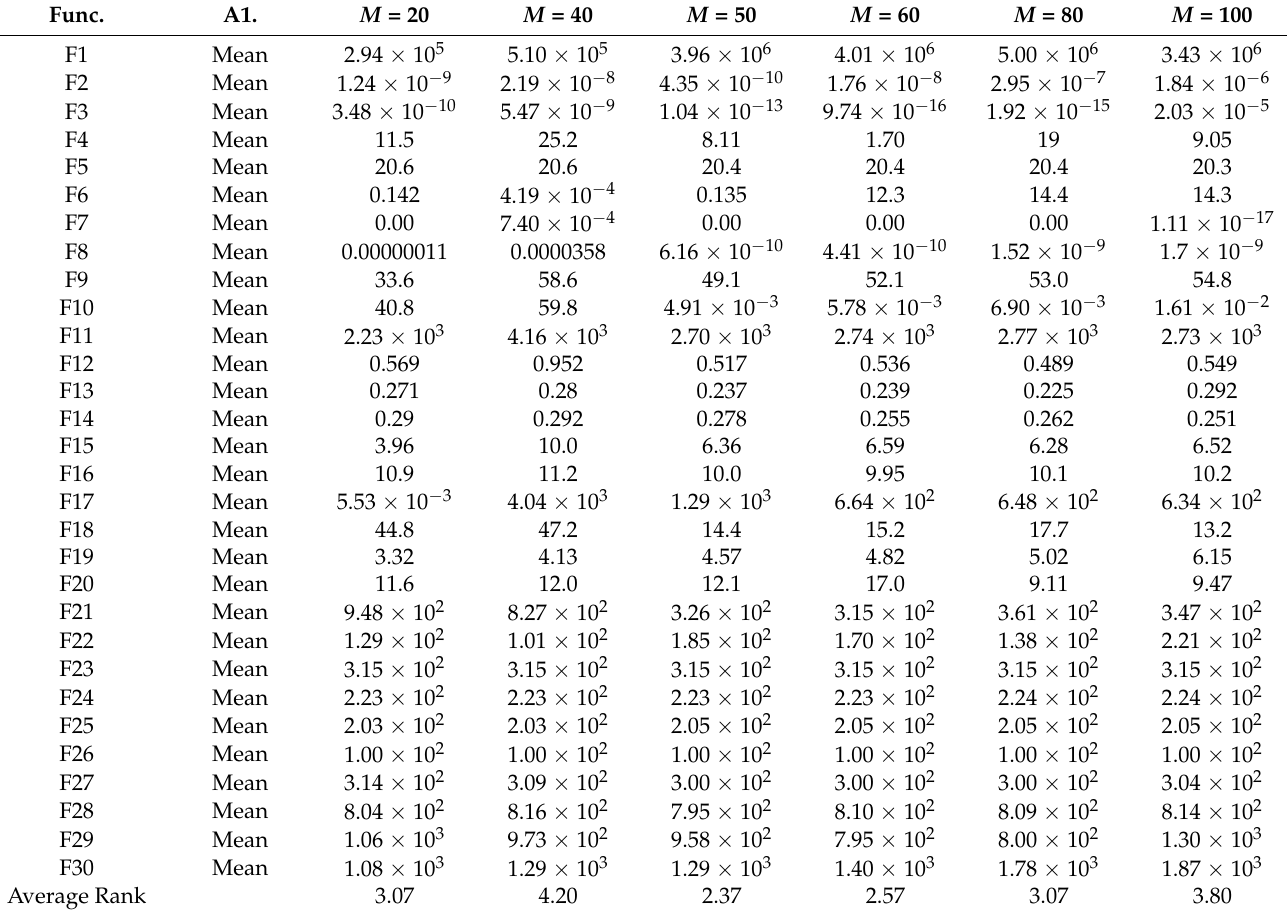
Table 1. The influence of parameter M